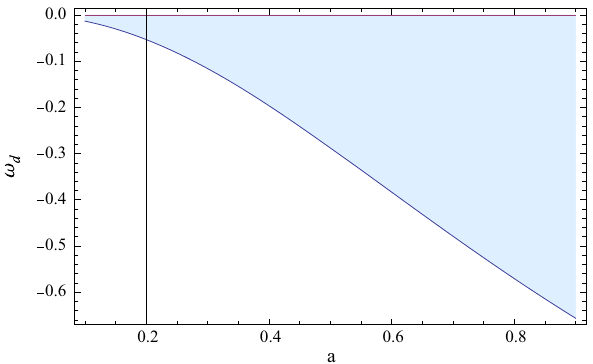
Fig. 2 The shaded region shows the valid region for ω d ( − 1 < ω d < 0 ) under stability criteria for (cid:6) d = 0 .